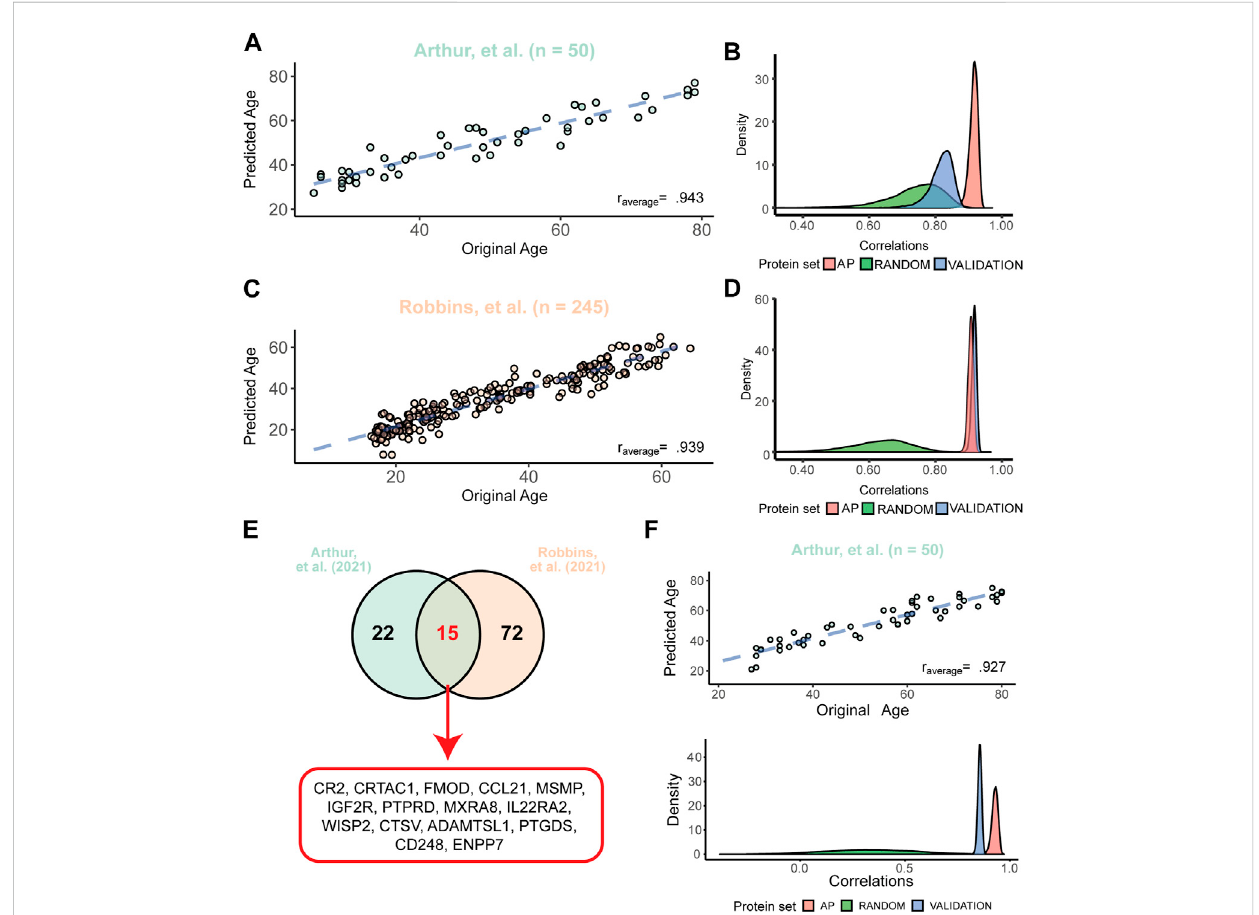
FIGURE 4 APs are better predictors of chronological age than other plasma proteins. (A) Example of the predicted versus the original age in the dataset of Arthur (Arthur et al., 2021) with the average correlation across 10,000 models. The blue dashed line depicts the fi t after correction for the model bias. (B) Distributionsof the10,000 correlations between theoriginal and the predicted ages obtained from models in Arthur (Arthur etal., 2021) usingall 273APs ( “ AP ” ),273randomplasmaproteins( “ Random ” )andthecorrelationofamodelfromonedatasettestedinRobbins(Robbinsetal.,2021)( “ Validation ” ). (C) Example of the predicted versus the original age in the dataset of Robbins (Robbins et al., 2021) with the average correlation across 10,000 models. Dashed line is similar as described in panel (A, D) Similar distributions obtained from models created in the Robbins dataset (Robbins et al., 2021) as described in panel (B) . Here, the validation was the correlation of models created in Robbins (Robbins et al., 2021) and applied to Arthur (Arthur et al., 2021). (E) Overlapbetweenthe mostused proteins across all 10,000 models for both datasets (usedin > 5,000 models), highlighting asignature of15 APs used inthereducedmodels. (F) Example of thestable proteomicclock performance in thedataset ofArthur (Arthur etal.,2021)consisting ofthe15 most used proteins as illustrated in panel (E) . Distributions below the correlation plot below illustrate the similar correlations obtained across all models as described in Panel (B) using the constant proteomic clock across all 10,000